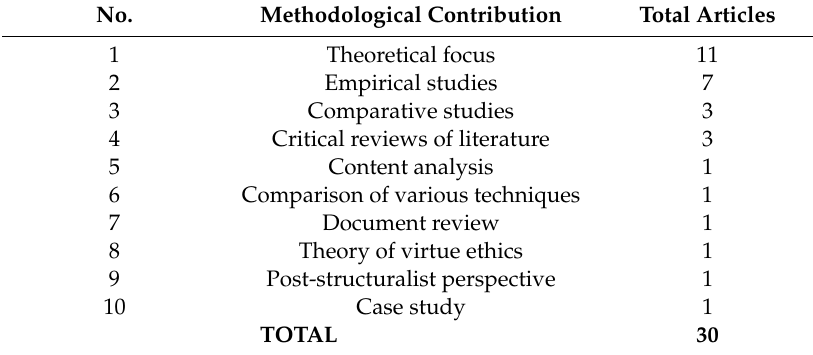
Table 5. Methodological